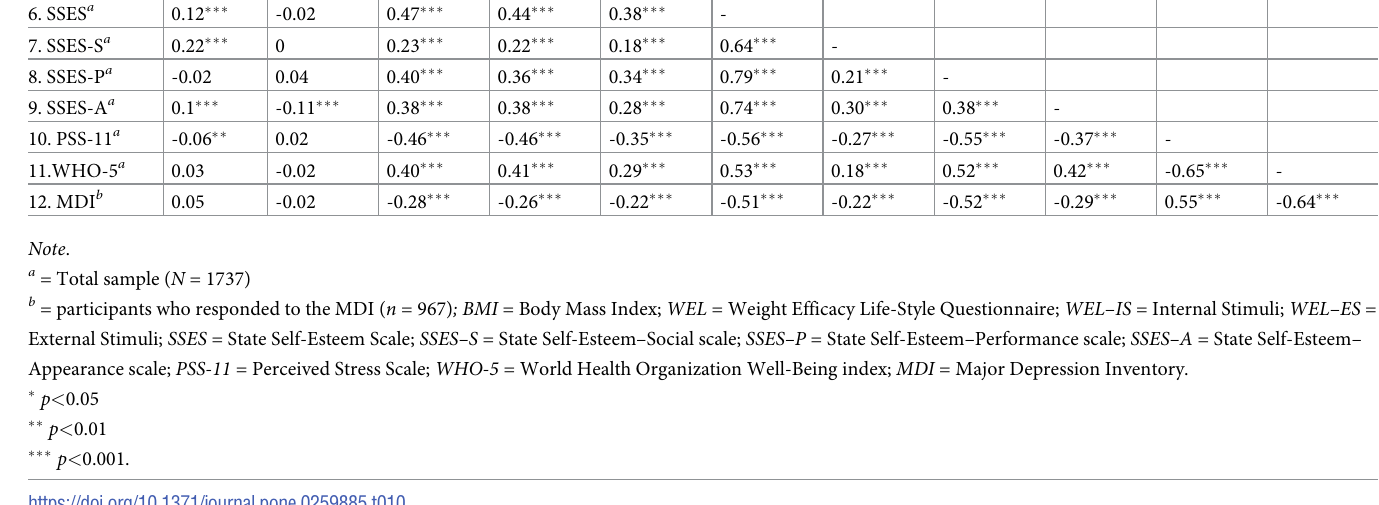
examine the links between the variables. The correlation coefficient values are displayed in Table 10. Age was positively but weakly correlated with the total WEL score ( rhô = 0.05) and its “Internal stimuli” subscale ( rhô = 0.06). BMI was negatively correlated with the “Internal stimuli” subscale only ( rhô = -0.08). The total WEL score and its two subscales were strongly correlated with each other. They also displayed identical correlation pattern with other variables. The total WEL score and the two subscales were positively correlated with the total SSES score ( rhô = 0.47; rhô = 0.44 and rhô = 0.38, respectively) and its three sub- scales “Social” ( rhô = 0.23; rhô = 0.22 and rhô = 0.18, respectively), “Performance” ( rhô = 0.40; rhô = 0.36 and rhô = 0.34, respectively) and “Appearance” ( rhô = 0.38 and rhô = 0.28). Additionally, they were positively correlated to the WHO-5 scale ( rhô = 0.40; rhô = 0.41 and rhô = 0.29, respectively). On the other hand, negative correlations were observed between the total WEL score, “Internal stimuli” and “External stimuli” subscales and the PSS-11 ( rhô = -0.46 and rhô = -0.35) and MDI scores ( rhô = -0.28; rhô = -0.26 and rhô = -0.22, respectively). Since the data were not distributed normally, non-parametric Kruskall-Wallis and Wil- coxon–Mann–Whitney U tests were used for mean comparison analyses. The results are displayed in Table 11. Significant differences of WEL scores were observed between the four BMI categories. Participants in Category III obesity had the lowest WEL scores when compared to Overweight participants or Category I obesity ( p = 0.026). However, the size effect of these differences was extremely small ( η 2 = 0.005). Likewise, when compared to the other three BMI categories, participants in category III obesity had the lowest eating self-efficacy towards internal stimuli ( p < 0.05) but the size effect of these differences was also very small ( η 2 = 0.008).